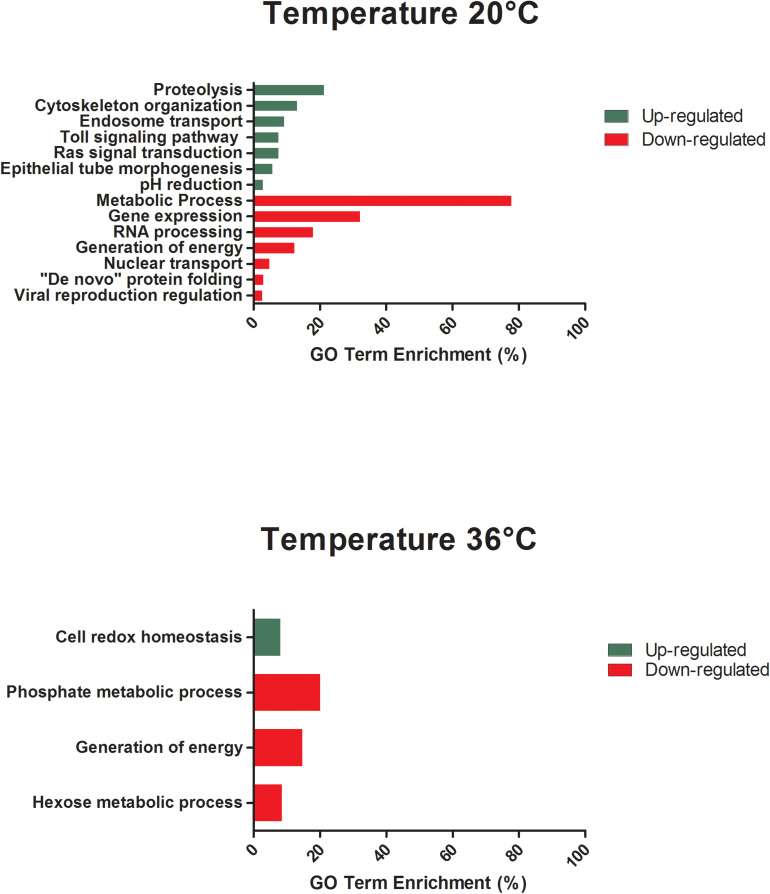
GO term enrichment analysis of differentially expressed genes of Aedes aegypti exposed to Zika virus under the lowest (20°C) and in the highest (36°C) temperature conditions in the category of biological processes for up- and down-regulated genes at 48 h.